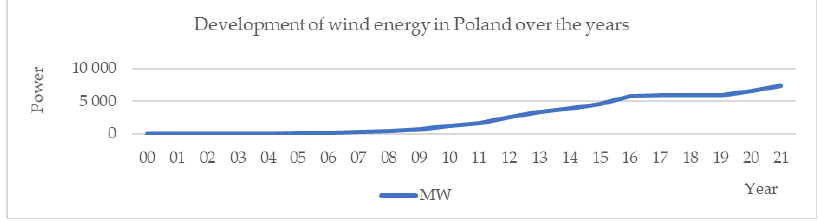
Figure 1. Development of wind energy in Poland.